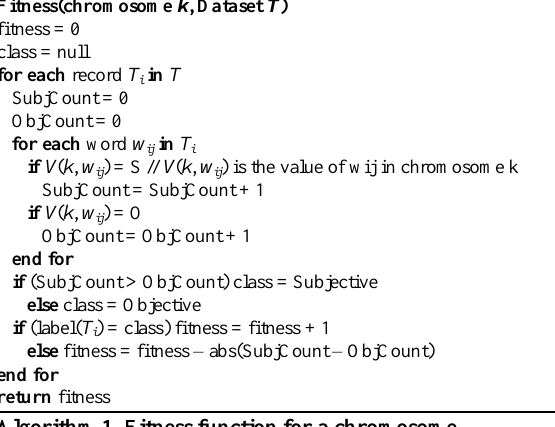
Algorithm 1. Fitness function for a chromosome